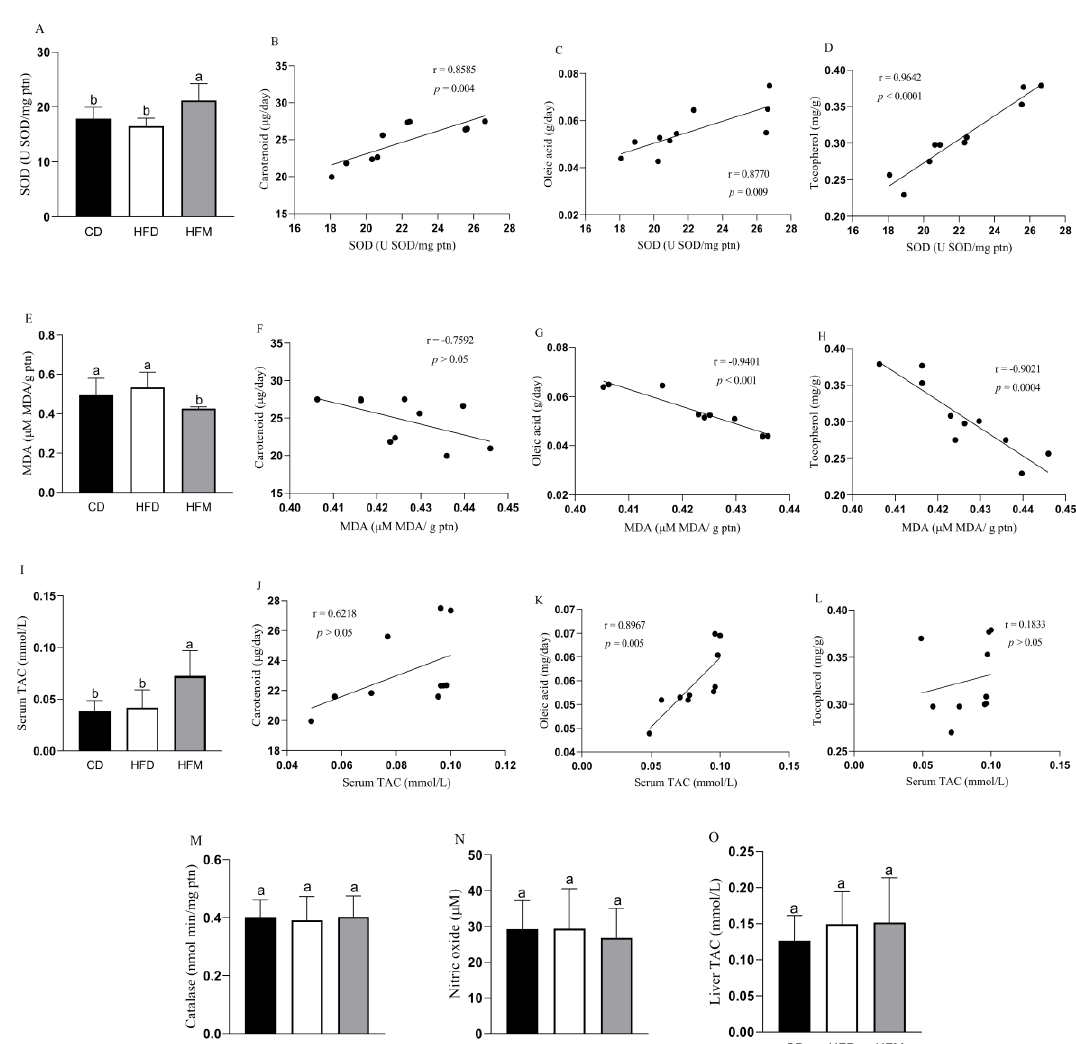
Figure 1. Oxidative stress level and antioxidant capacity of mice after consuming the experimental diets for 8 weeks, and correlation with carotenoid, oleic acid, and tocopherol intakes. ( A ) Superoxide dismutase level. ( B ) Correlation between SOD level and carotenoid intake. ( C ) Correlation between SOD level and oleic acid intake. ( D ) Correlation between SOD level and tocopherol intake. ( E ) Malondialdehyde level. ( F ) Correlation between MDA level and carotenoid intake. ( G ) Correlation between MDA level and oleic acid intake. ( H ) Correlation between MDA level and tocopherol intake. ( I ) Serum total antioxidant capacity level. ( J ) Correlation between serum TAC level and carot- enoid intake. (K) Correlation between serum TAC level and oleic acid intake. (L) Correlation be- tween serum TAC level and tocopherol intake. (M) Catalase level. (N) Nitric oxide level. (O) Liver total antioxidant capacity level. Data are expressed as mean ± standard deviation (n = 10). Different letters indicate a statistical difference based on the Newman – Keuls test ( p ≤ 0.05). CD: control diet — AIN93M; HFD: high-fat diet; HFM: high-fat diet with macauba pulp oil; SOD: superoxide dis- mutase; MDA: malondialdehyde; TAC: total antioxidant capacity.